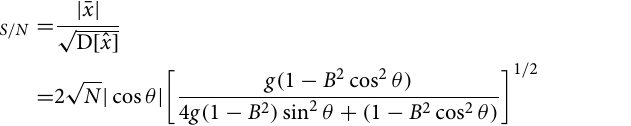
2.5 is assumed in =